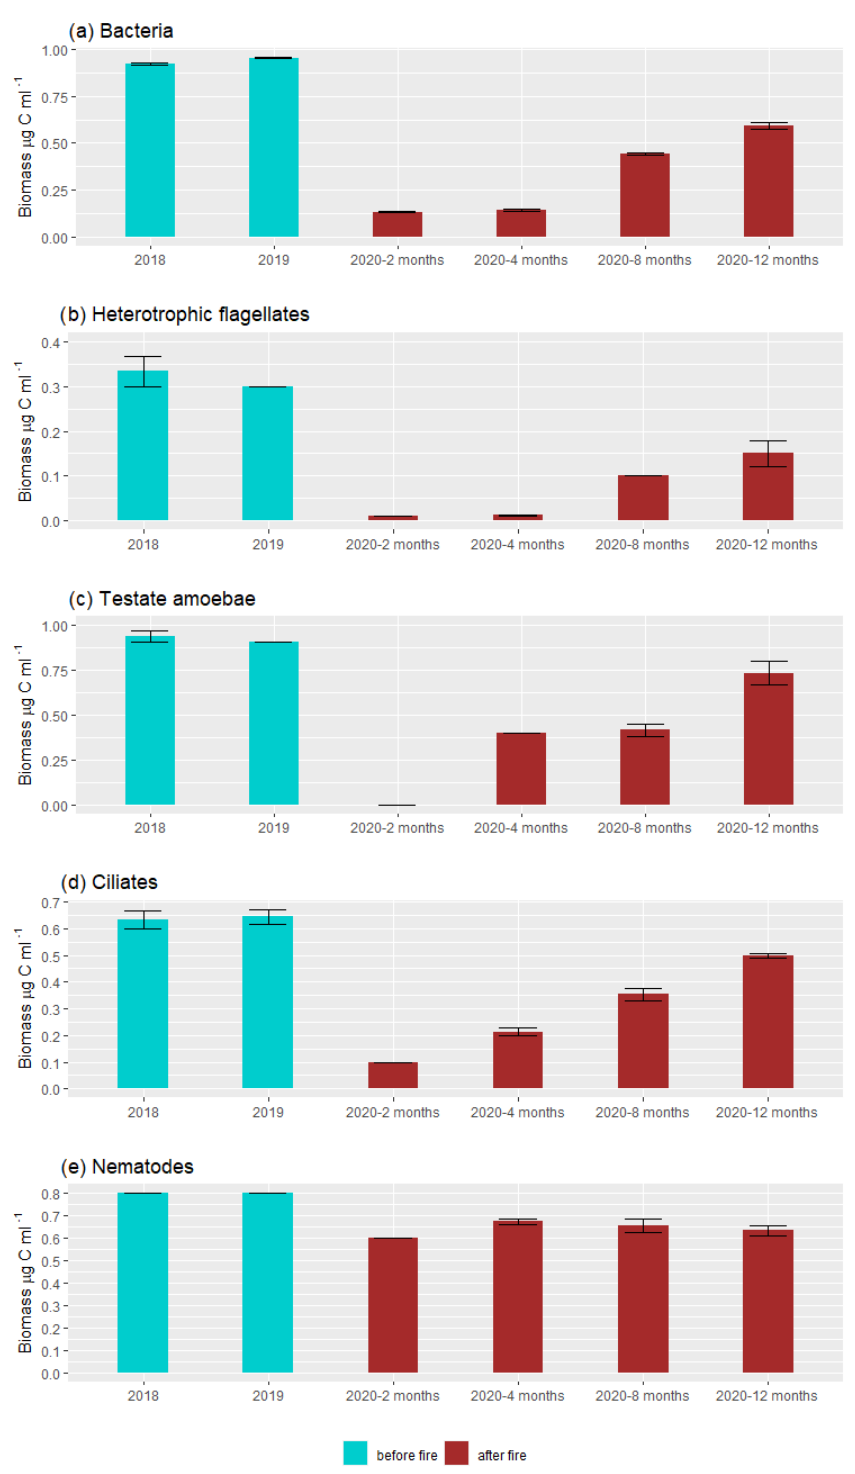
Figure 4. Barplot with error bars for biomass of ( a ) bacteria; ( b ) heterotrophic flagellates; ( c ) testate amoebae; ( d ) ciliates; ( e ) nematodes before and after fire. Significantly higher abundance and biomass of bacteria were recorded before the fire (7.5 ± 2.2 × 10 6 cells mL −1 and 0.93 ± 0.36 µg C mL −1 , respectively). After the fire, there was a sharp decline in the abundance and biomass of bacteria to 0.5 ± 0.01 × 10 6 cells mL −1 and 0.13 ± 0.002 µg C mL −1 . A significant increase in the abundance and biomass of bacteria was noted 8 months after the fire, reaching 5.5 ± 2.1 × 10 6 cells mL −1 and 0.53 ±